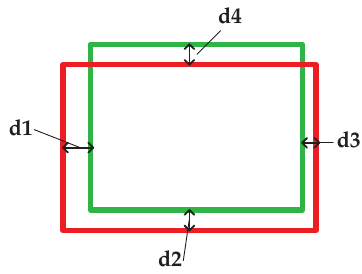
Figure 12. Evaluation of a reconstructed opening. The red frame represents the manually labeled opening. The green frame represents the reconstructed opening. The distances between the left, bottom, right, top edges of the two openings are labeled as d1, d2, d3 and